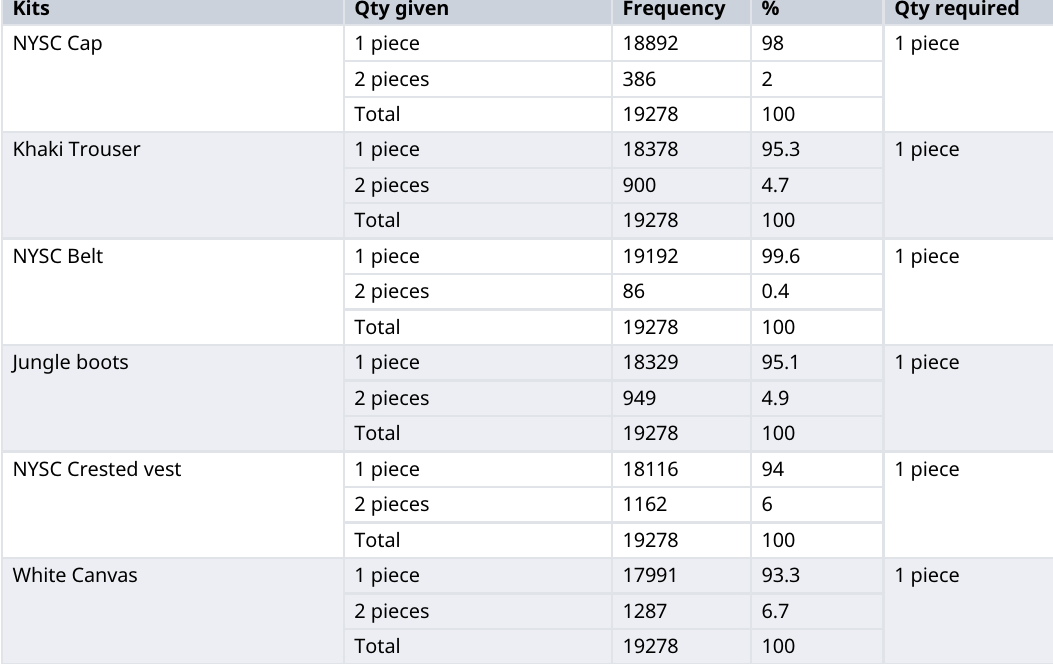
Table 5. Participants ’ responses on the quantity (Qty) of kits given to them during NYSC service. Kits